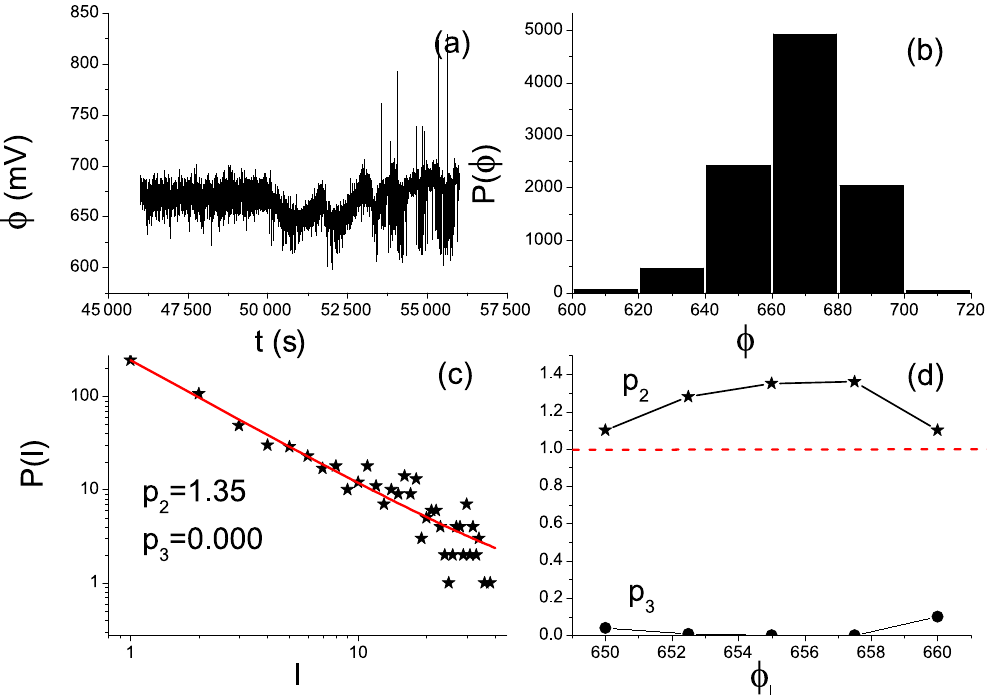
Figure 2. (a) The 10000-sample long critical window of the MHz EME that was recorded before the Cephalonia M w = 6 . 0 EQ at the Cephalonia station. (b) Amplitude distribution of the signal of Fig. 2a. (c) Distribution of laminar lengths for the end point φ l = 655mV, as a representative example of the involved fitting. The solid line corresponds to the fitted function (cf. text in Sect. 2.1) with the values of the corresponding exponents p 2 , p 3 also noted. (d) The obtained exponents p 2 , p 3 vs. different values of the end of laminar region φ l . The horizontal dashed line indicates the critical limit ( p 2 = 1 )